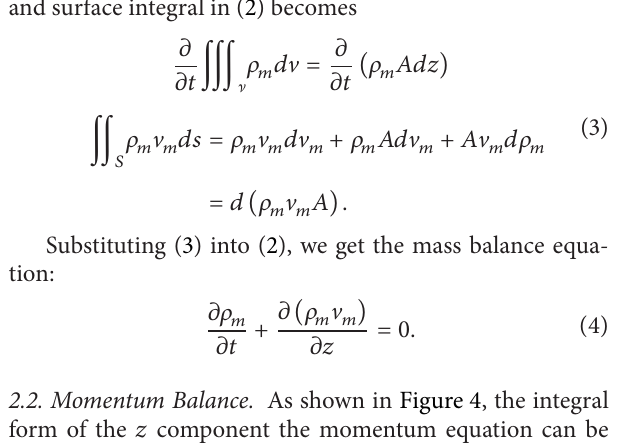
Figure 2: Control volume 1.